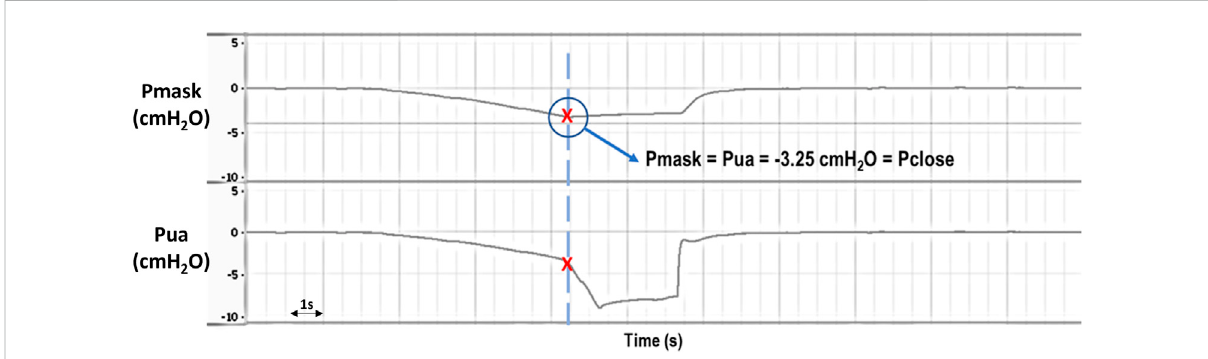
FIGURE 3 Representative raw data example showing Pmask (mask pressure) and Pua (upper airway pressure) during application of negative intraluminal pressure for Pclose (closing pressure) determination. Initially, Pmask and Pua decrease at the same rate as increasing negative pressure is being applied to the upper airway, indicating an open airway. Eventually there is a deviation in Pua and Pmask, with a sudden drop in Pua while Pmask stabilizes, indicating that the upper airway has closed (i.e., Pclose = − 3.25 cmH 2 O in this example). Pmask and Pua were later retuned to 0 cmH 2 O when the system was opened to